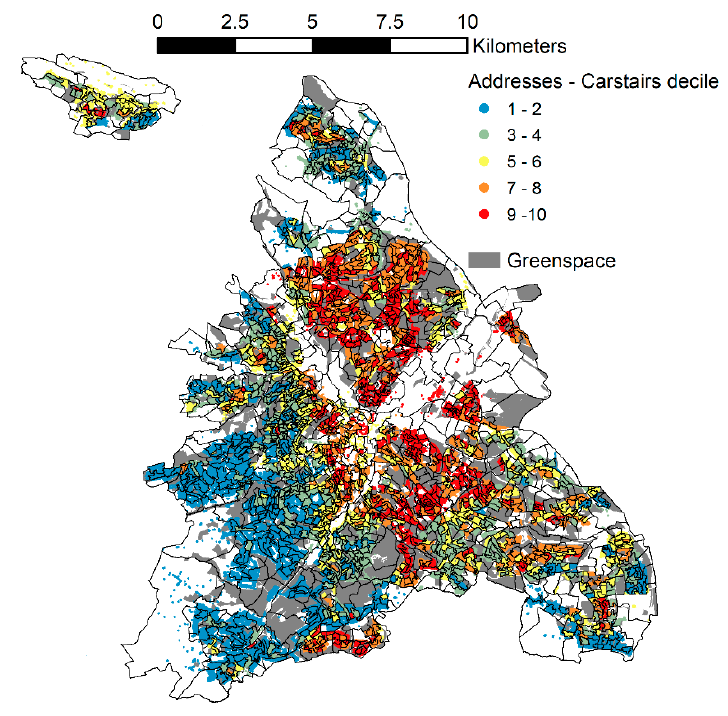
Figure 2. The urbanised Output Areas (OAs) of Sheffield (classed as ‘urban’), with locations of households (coloured according to Carstairs deprivation index decile) and greenspaces.